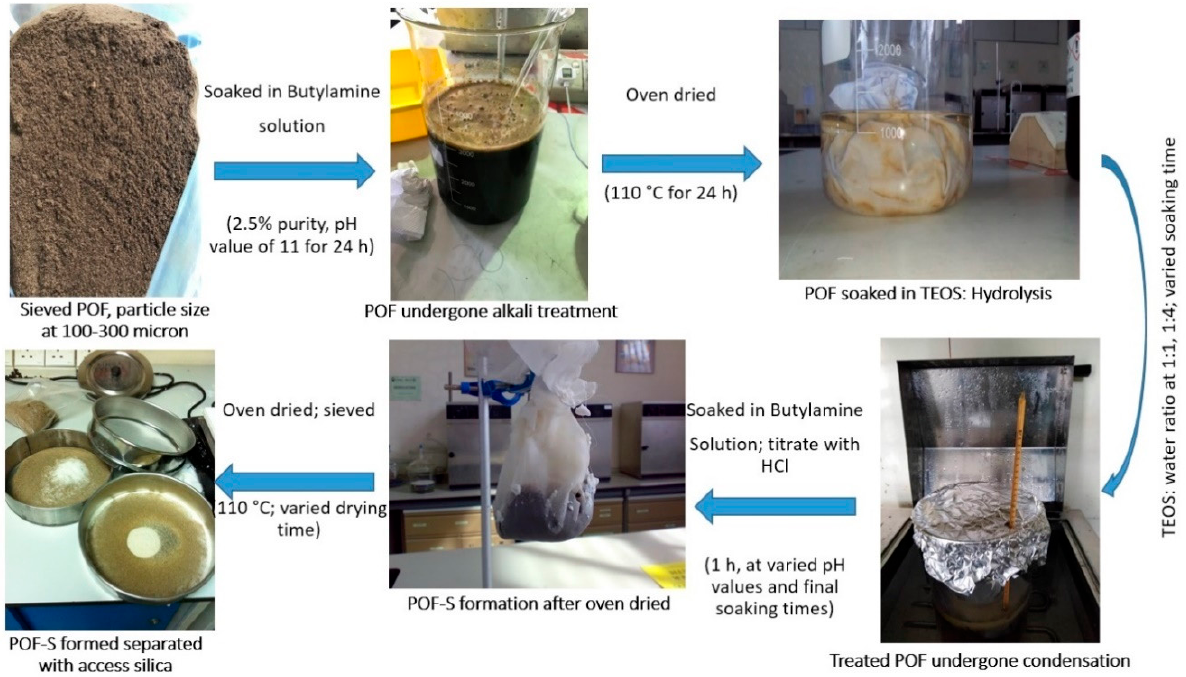
Figure 2. Schematic diagram of the production of OPF and OPF-S conducted through sol-gel process.